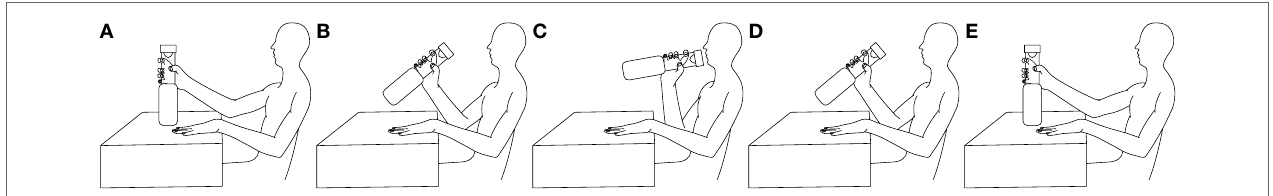
FIgURe 3 | experiment setup: while remaining seated in front of a table, (A) the child reaches forward with his/her right hand until he/she grasps the glass, (B) lifts it off the table, and (c) transports it to the mouth . After that, (D) he/she returns the device and (e) releases it on the